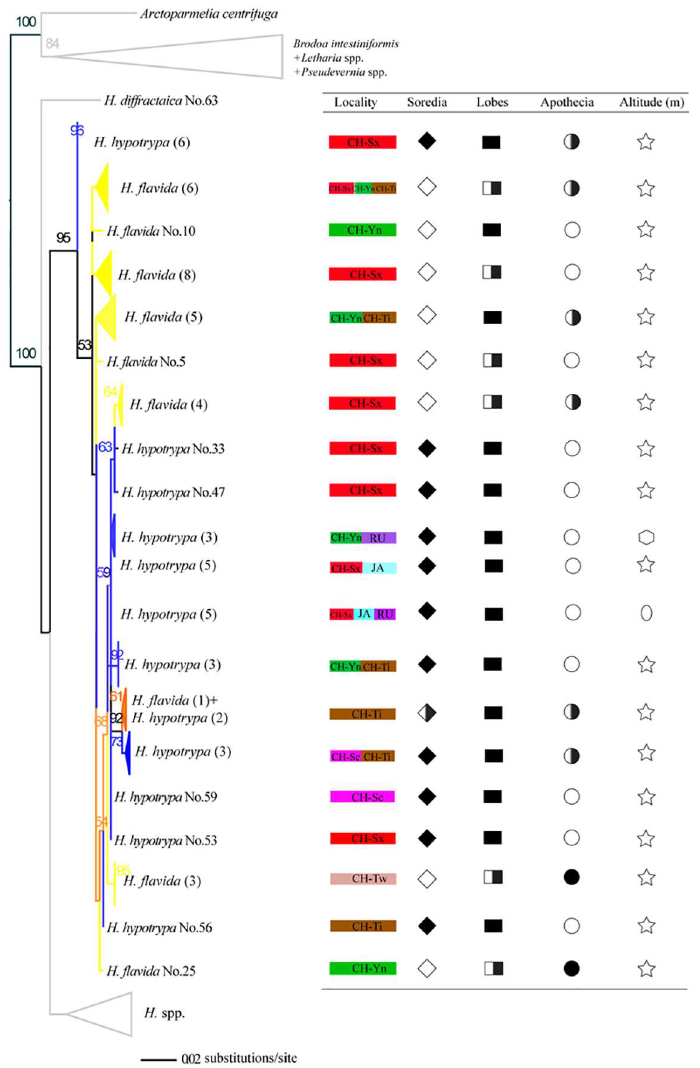
Fig 5. Cartoon topology of ML phylogenetic tree based on nrDNA ITS. The numbers in each node represents bootstrap support value, and the numbers lower than 50 were not shown. The number of each sample (i.e. No.) is listed in S1 Table, while the number in the bracket indicatesthat the amount of samples corresponding to the same species in the same sub-branch. Three colors are includedin the branches (blue = H . hypotrypa , yellow = H . flavida , orange = both H . hypotrypa and H . flavida ). The branches of other species of Hypogymnia and outgroupare shown in gray color. Right table indicates the collection locality information and main morphological characters delimiting H . hypotrypa and H . flavida . Red = Shaanxi Province of China (CH-Sx), green = Yunnan Province of China (CH-Yn), purple-red = Sichuan Province of China (CH-Sc), brown = Tibet of China (CH-Ti), pink = Taiwan of China(CH-Tw), pale blue = Japan (JA), purple = Russia (RU). Soredia is indicatedby ◇ ( ◇ = absence, ◆ = presence, half filled ◇ = absence sometimes), lobes by & ( & = wide, half filled □ = both wide and fingerlike), and apotheciaby (cid:14) ( (cid:14) = absence, ● = presence, half filled (cid:14) = absence sometimes). ☆ , shows all the samples in the sub-branchdistribute at the high altitude (more than 2000 meters high); hexagon, part at the middle altitude (about 500 m); oval, part at low altitude (about 50